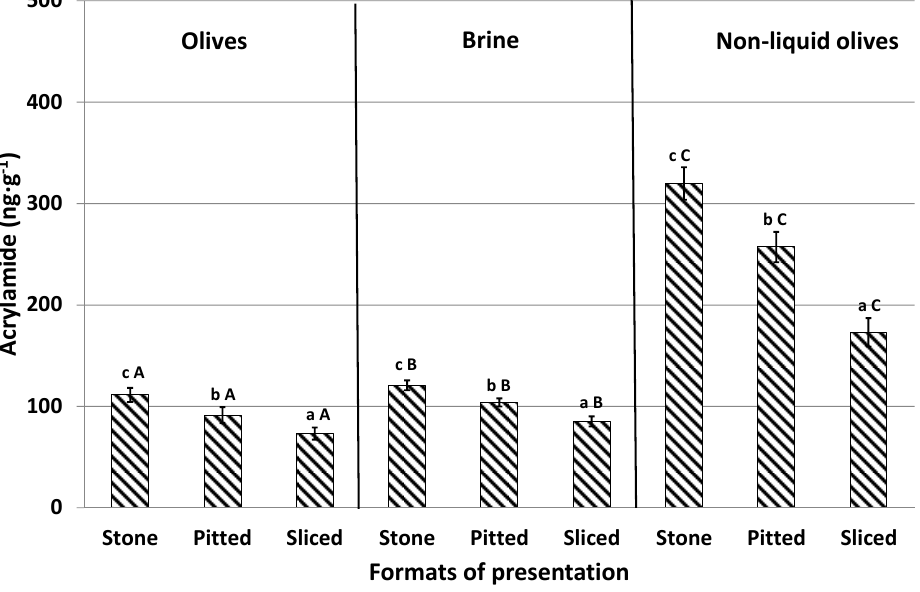
different presentation formats.